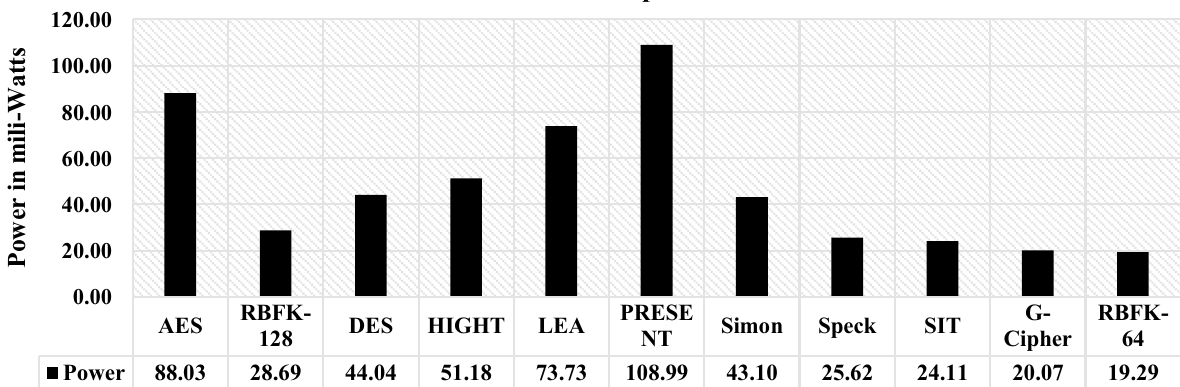
Fig. 15 Power consumption comparison of